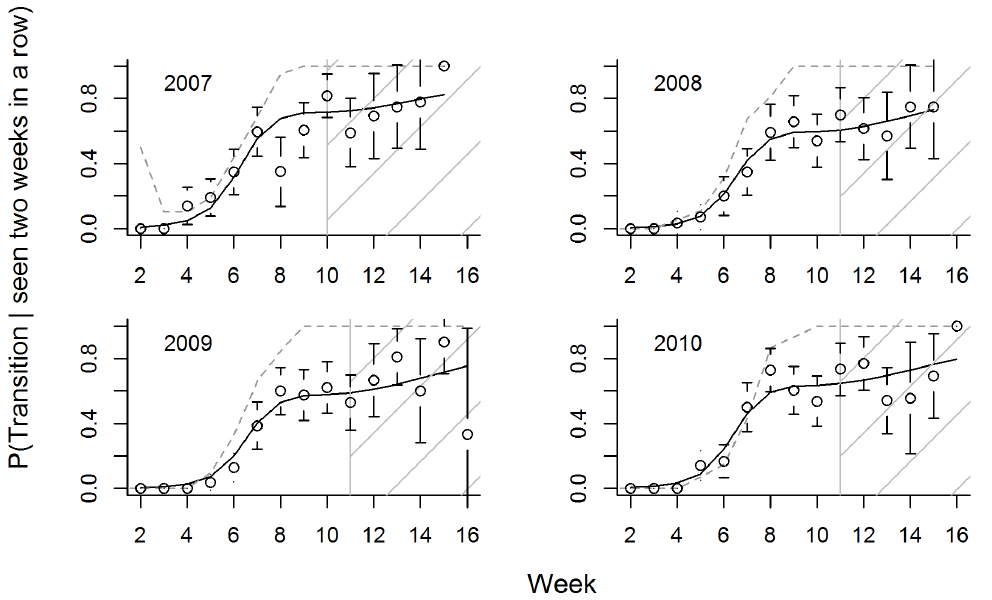
Figure 2. Probabilities that juvenile ring-necked ducks changed lakes, given observation in 2 successive weeks. Open circles correspond to observed proportions (with 95% confidence intervals). Solid black line gives predictions from the ‘best-fit’ generalized estimating equation model (chosen using QIC). The gray dotted line represents the proportion of marked birds flighted each week in the falls of 2007–2010. The gray vertical line (and hatched fill) demarcates the hunting season.